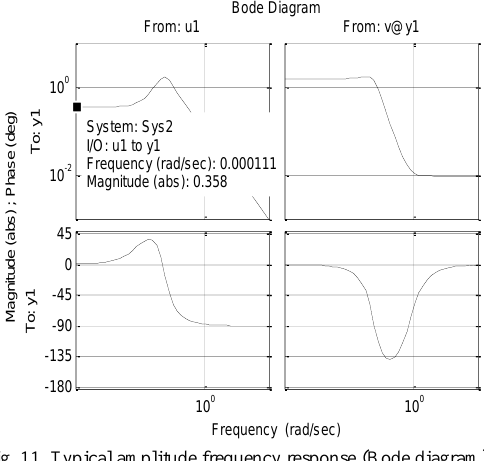
Fig. 10. The input-output model of a friction dynamic system.